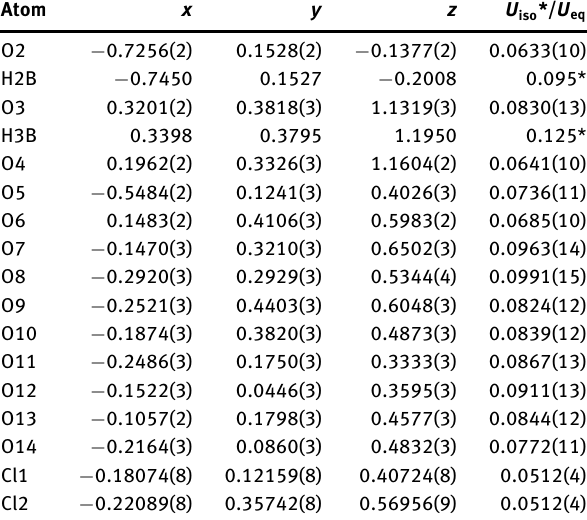
Table 2: Fractional atomic coordinates and isotropic or equivalent isotropic displacement parameters (Å 2